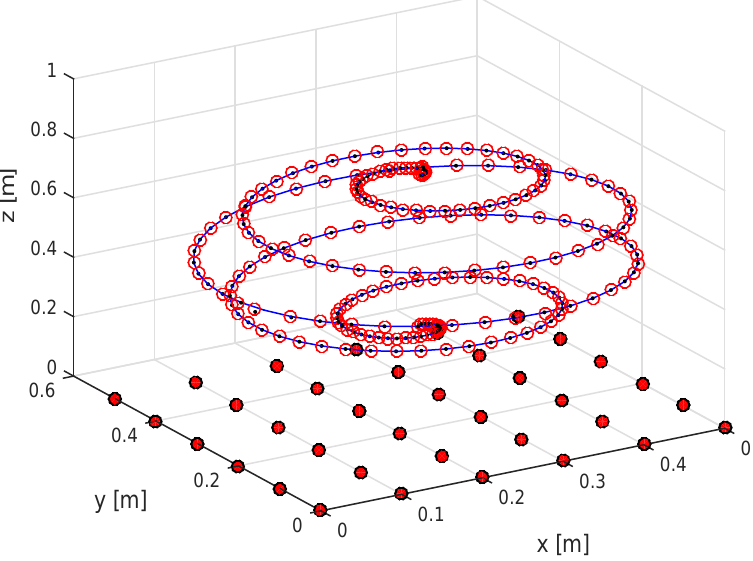
Figure 4. Trajectory used for the numerical simulations. Sensing coils are placed on the xy plane and denoted by red-filled circlets. The true trajectory of the field-generating coil is marked as a solid blue line, the trajectory estimated by the mutual inductance method by black dots, and that estimated by the magnetic dipole method by red